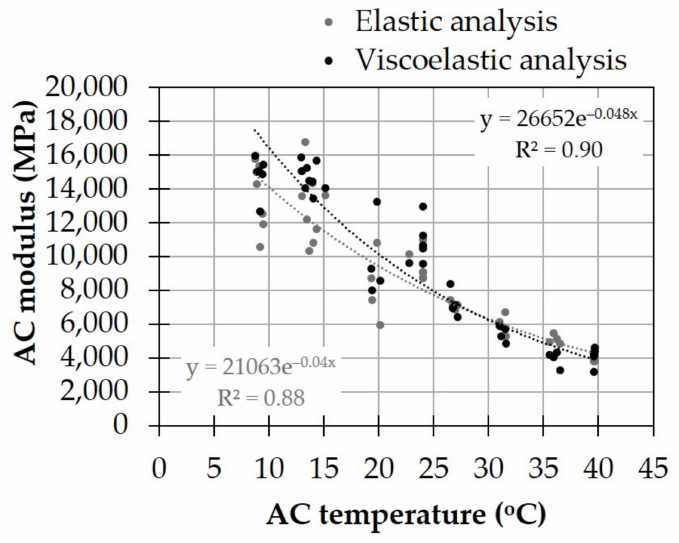
Figure 9. AC modulus variation against AC temperature for both analysis